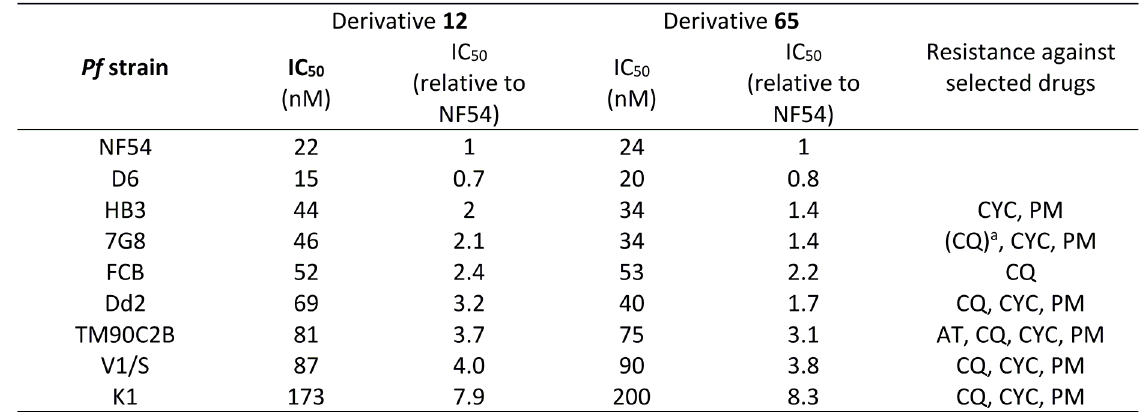
Resistance profile for compounds 12 and 65.